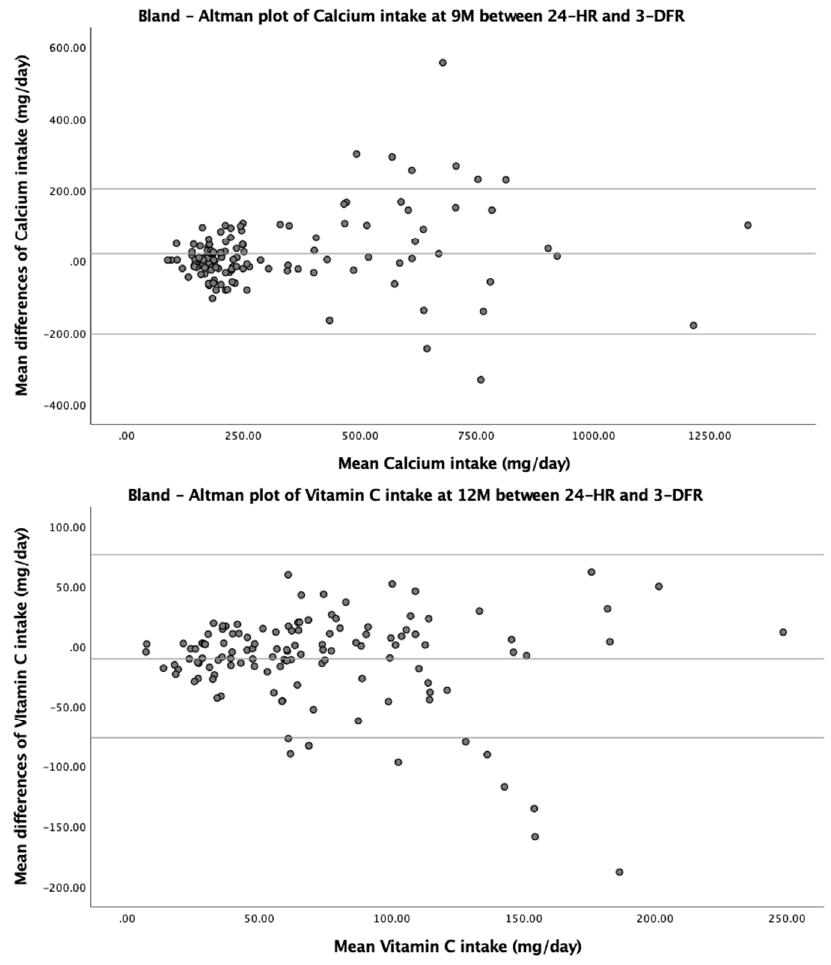
Figure 1. Bland–Altman plots showing the proportional biases of calcium intake at 9 M and vitamin C intake at 12 M. Table 5. Cross-classification and Spearman’s correlations of nutrient intakes compared between 24-HR and Table 3. Agreements of energy and nutrient intakes between 24-HR and 3-DFR.